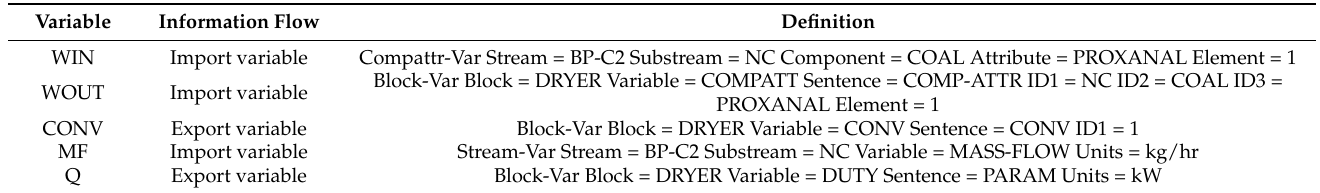
Table A7. Variables used in calculator block DRY - C